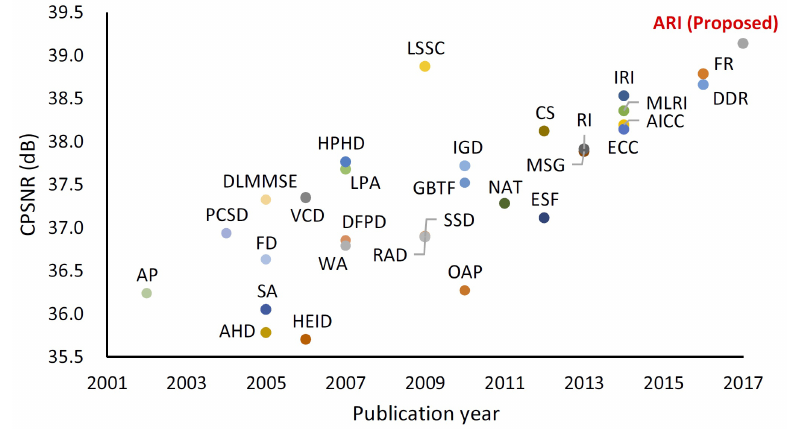
Figure 1. Performance of the demosaicing algorithms over the years (from the analysis presented in [14]). Image source: